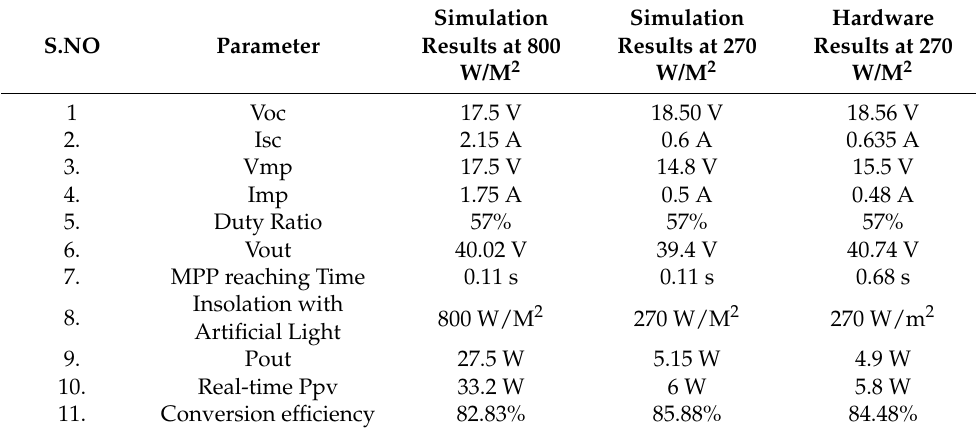
Figure 17. ( a ) Real-time PV curve; ( b ): real-time IV curve. Comparative studies of hardware and software results of DC P&O technique at 270 W/M 2 are shown in Table 4. Due to hardware limitations the experiment was not per- formed, only a simulation study was conducted at 800 W/M 2 .